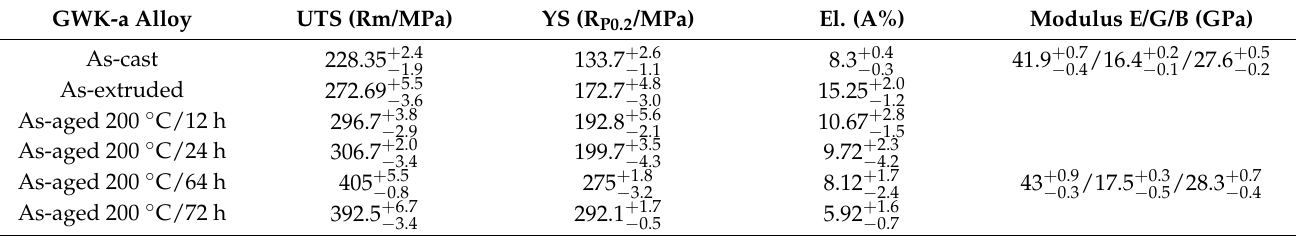
Table 2. Tensile properties of as-cast, as-extruded and as-aged GWK alloys at room